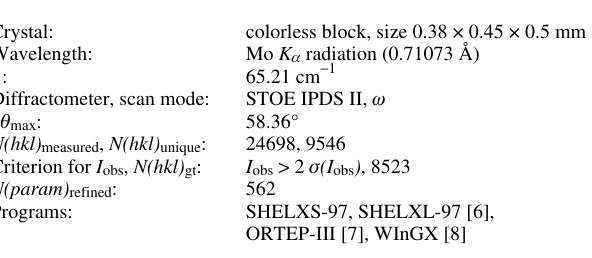
Table 1. Data collection and